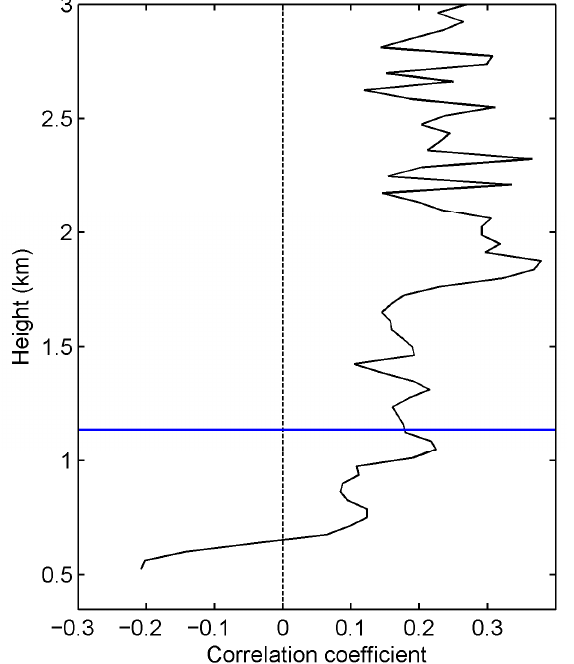
Figure 8. The vertical distribution of correlation coefficients between the daily average ozone concentrations and extinction coefficients over the Lidar observation period. The blue solid line represents the average PBLH.